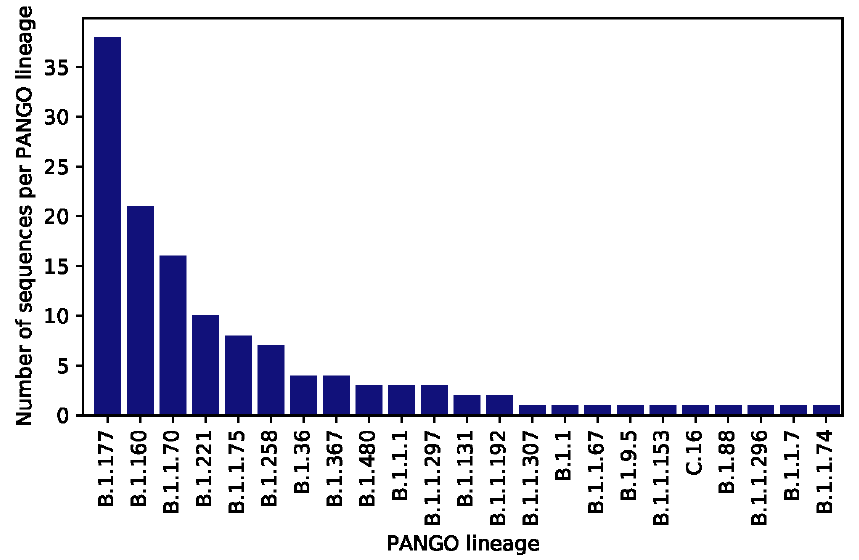
Figure 2. SARS-CoV-2 lineage distributions: Absolute number of sequences obtained within this study with the indicated pangolin classification.